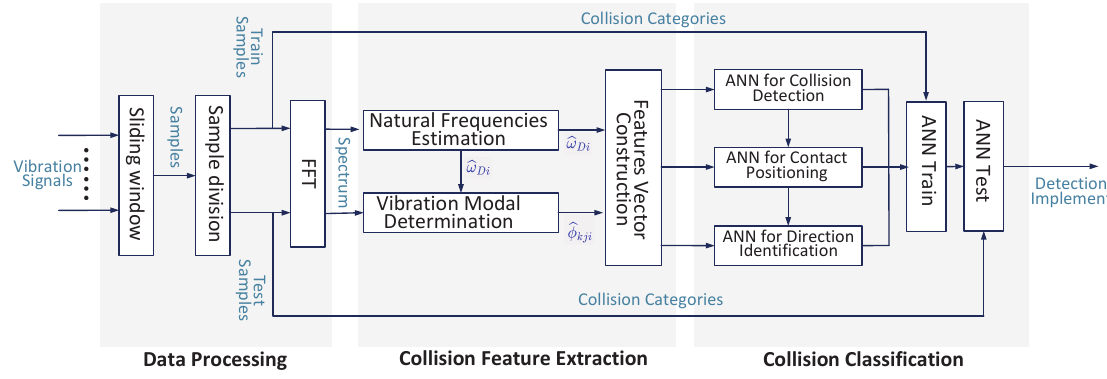
Figure 5. Vibration signal based detection